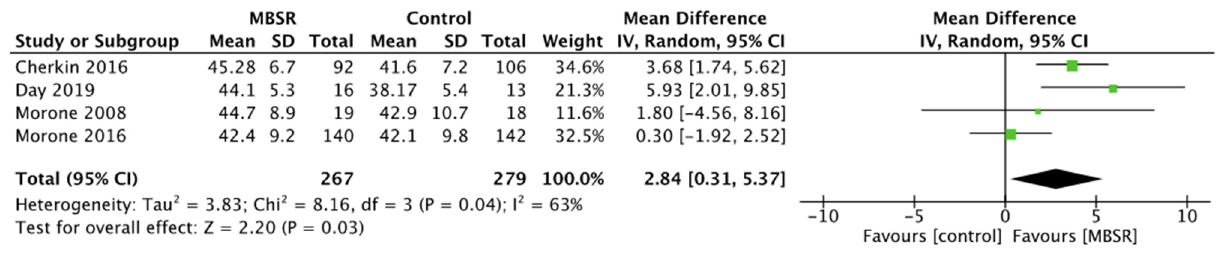
Figure 7. Quality of Life: CBT versus control.